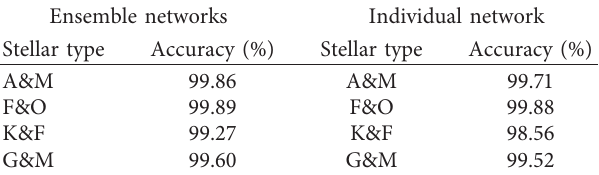
Table 4: Classification results of comparison. Ensemble